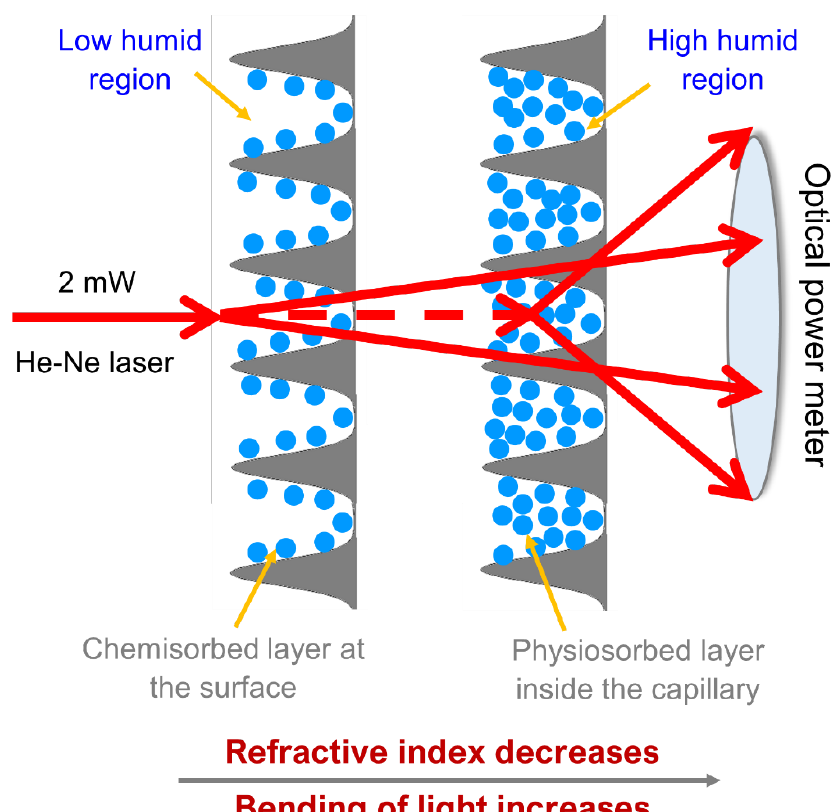
Figure 18. Humidity sensor’s sensing mechanism. The picture shows, for less humid regions, chemisorption and less bending of light. For high humid regions, physisorption and greater bending of light were observed. (Adapted with permission from [50], Copyright 1969, IEEE)